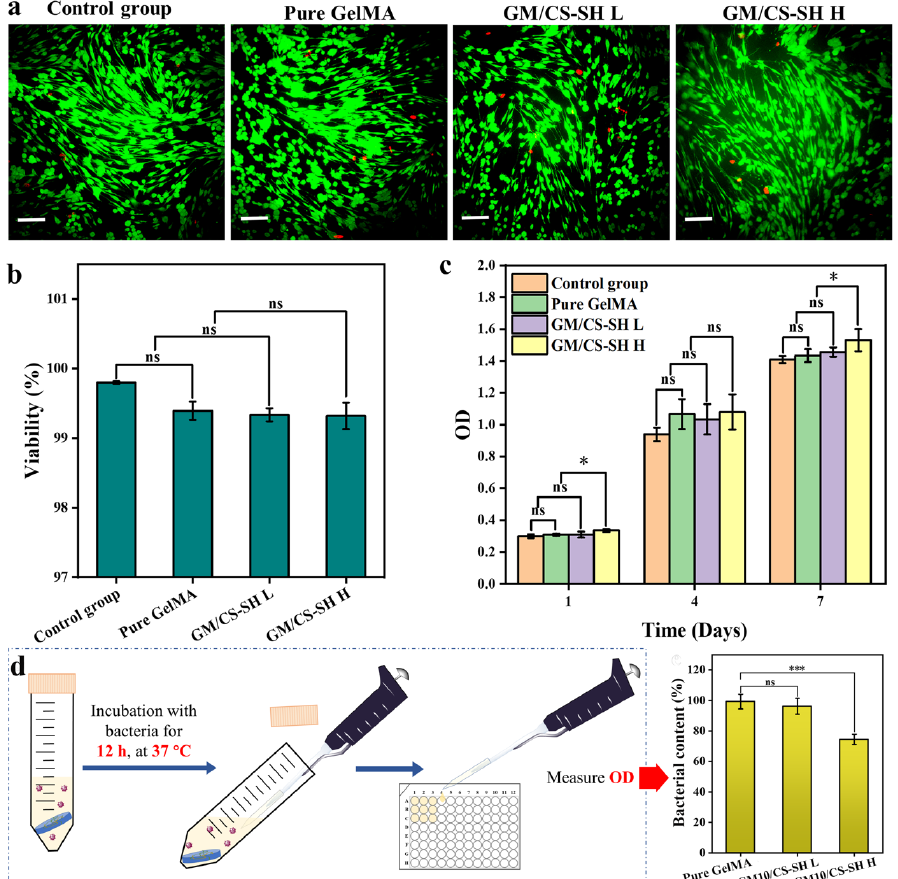
Figure 4. In vitro biocompatibility and antibacterial property. ( a ) Live/dead assay of BMSCs cultured with extract of hydrogel, the red dots means dead cells, scale bar: 100 μm. ( b ) The viability and ( c ) the proliferation of ASCs cultured with extracts of GelMA, GM/CS-SH L, and GM/CS-SH H. ( d ) Schematic of the antibacterial property test of the hydrogels and the turbidity of the medium when cultured for 12 h. (Statistical significance was calculated via one-way ANOVA using Bonferroni’s post hoc test, ns: no statistical difference, * p < 0.05, *** p < 0.001.) All data are presented as mean ±